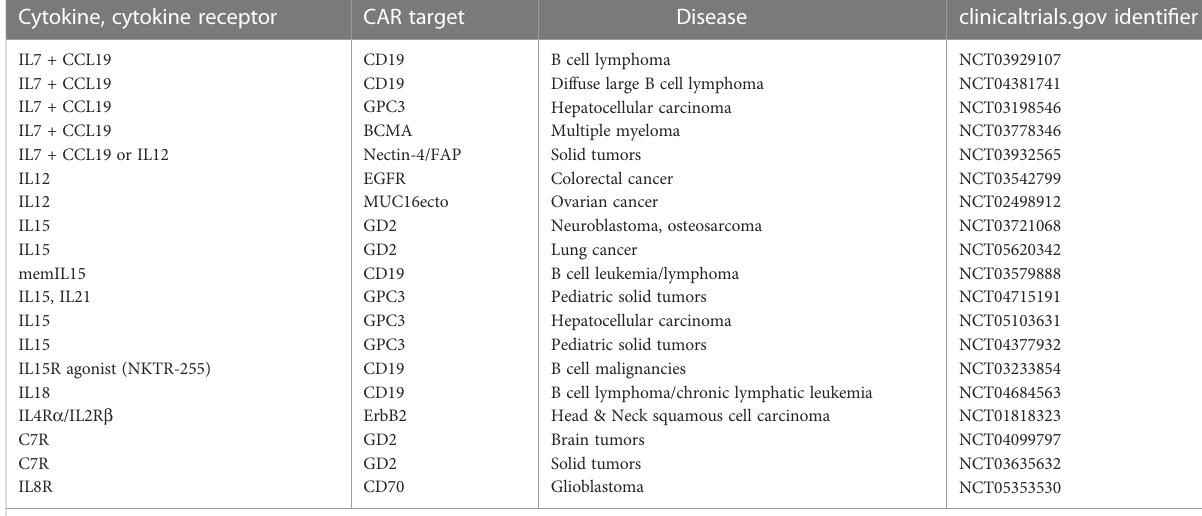
TABLE 1 Selected CAR T cell trials exploring the safety and ef fi cacy of added cytokine or cytokine receptor ( “ signal-3 ” ). Cytokine, cytokine